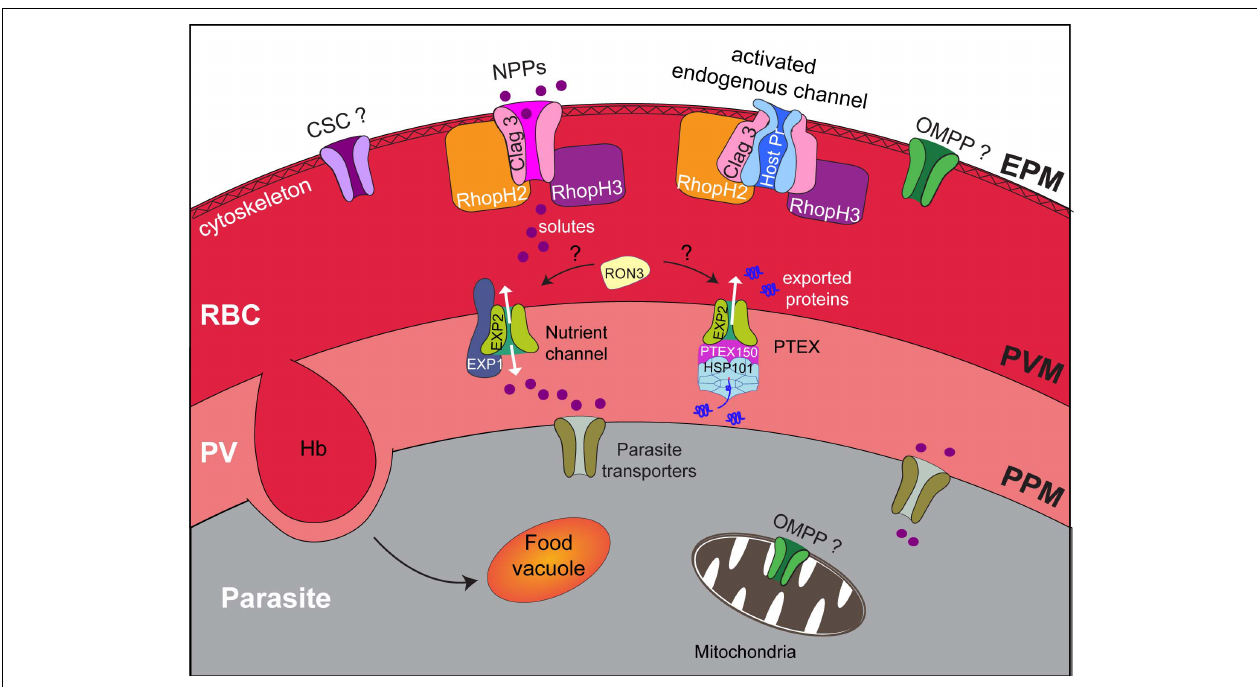
FIGURE 2 | Nutrient acquisition by P. falciparum relies on membrane transporters and the cytostome. Upon infection by Plasmodium parasites, erythrocytes are extensively remodeled to accommodate the growing parasite. The parasite, contained by its own PPM, is encased within a parasitophorous vacuole (PV) and a PV membrane (PVM). Each membrane in the infected erythrocyte, including the erythrocyte plasma membrane (EPM), is modified to include transporters that enable the parasite to access nutrients from its host. These include the NPPs at the EPM, the nutrient channel at the PVM, and transporters at the PPM, whereas hemoglobin uptake and transport to the food vacuole occur via the cytostome. The NPP channel is proposed to be a CLAG3 dimer/oligomer that associates with RhopH2 and RhopH3. Alternatively, CLAG3, RhopH2, and RhopH3 may activate an endogenous host channel. The contribution of other parasite-encoded channels to the NPPs such as the calcium-dependent, stress-gated ion channel (CSC), and OMPP is unknown; the localization of both of these proteins is yet to be ascertained. The nutrient channel at the PVM comprises EXP2, with EXP1 being critical for proper distribution of the EXP2 nutrient channel. EXP2 also forms the pore of the translocon of exported proteins (PTEX). RON3 is implicated in both nutrient uptake across the PVM and protein export with an unknown function. The PPM is also decorated with a raft of transporters that facilitate the uptake of diverse substrates to satisfy the metabolic requirements of the growing